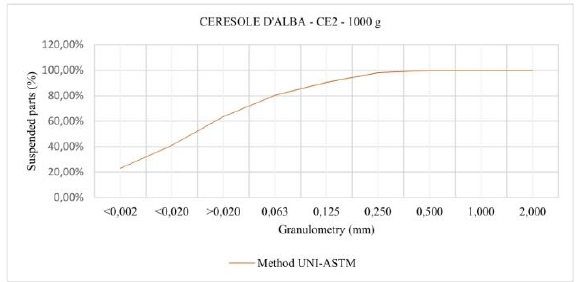
Figure 6. Selected soils grain size distribution – Method UNI- ASTM, reworking of the authors.